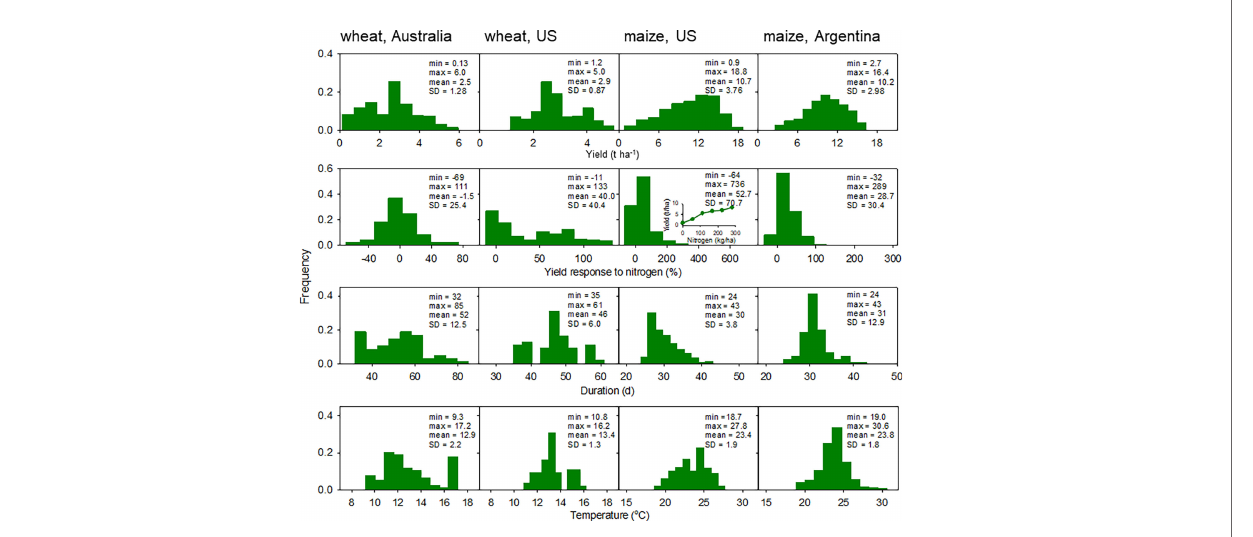
FIGURE 1 | Frequency distribution of yield, yield response to nitrogen, duration of the critical period and mean temperature during the critical period for spring wheat in Australia (n = 384), winter wheat in US (n = 224), maize in the US (n = 1165), and maize in Argentina (n = 984). Yield response to nitrogen is 100 · (Y N -Y 0 )/ Y 0 , where Y is grain yield and subscripts indicate fertilised (N) and unfertilised control (0). Inset for yield response to nitrogen for maize in the US highlights the large response for rainfed crops after cereal in a sandy soil with low organic matter, where yield increased 8-fold from unfertilised control to crops with 280 kg N ha -1